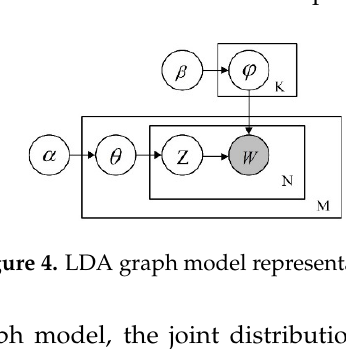
Figure 3. The schematic of the topic representation of the images.